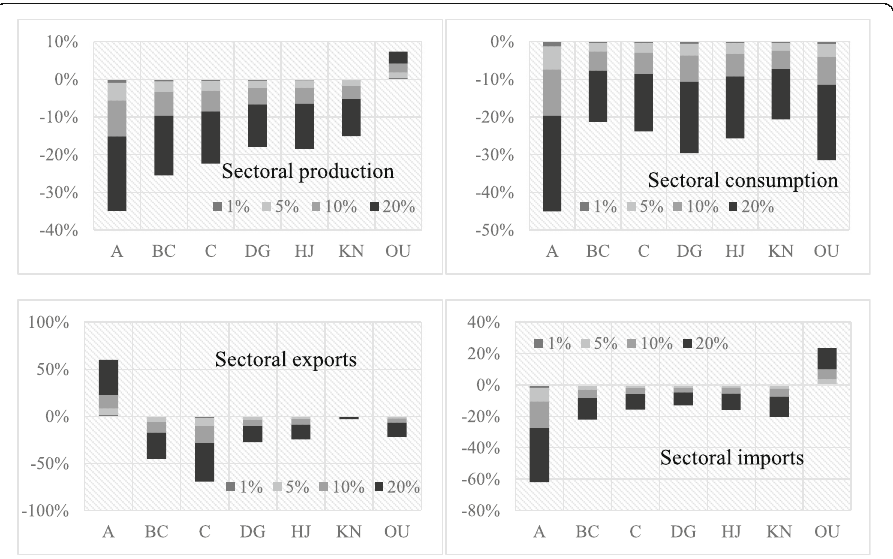
Fig. 6 Simulated sectoral effects of tax on polluting good. (Source: authors calculations based on CGE model simulations